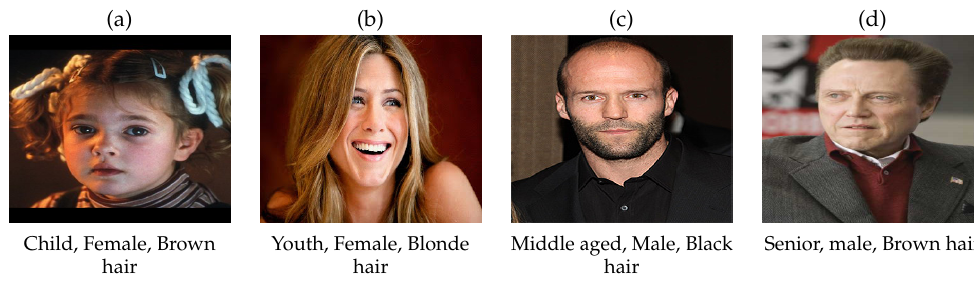
Figure 4. Predicted results of middle-level attributes of humans.